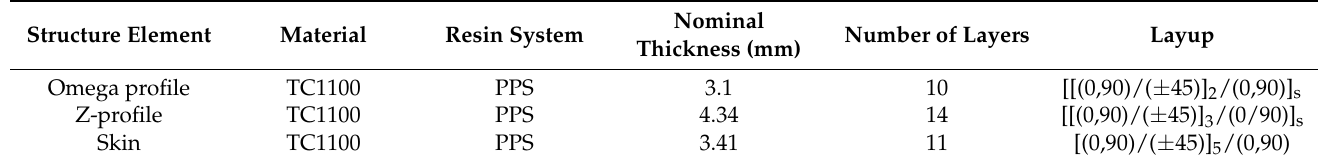
Table 1. Overview of composite materials used for door panel manufacturing.